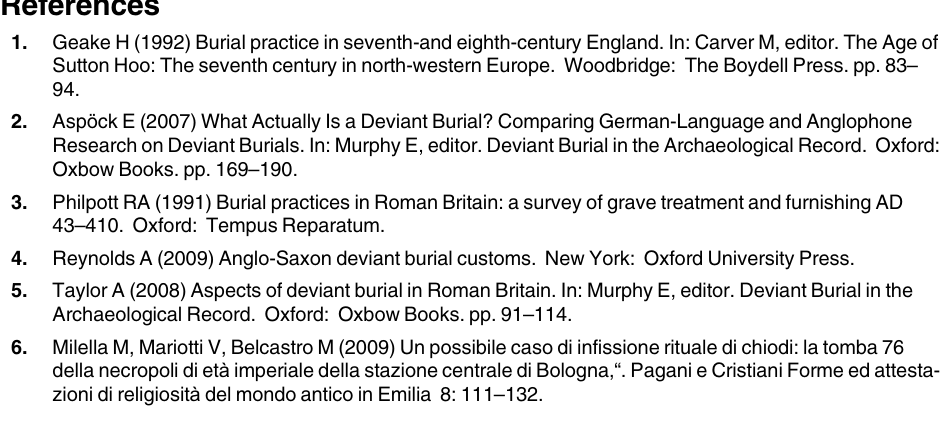
S1 Table. Dataset of irregular burials considered in this study. Burial ID: "x" = no burial